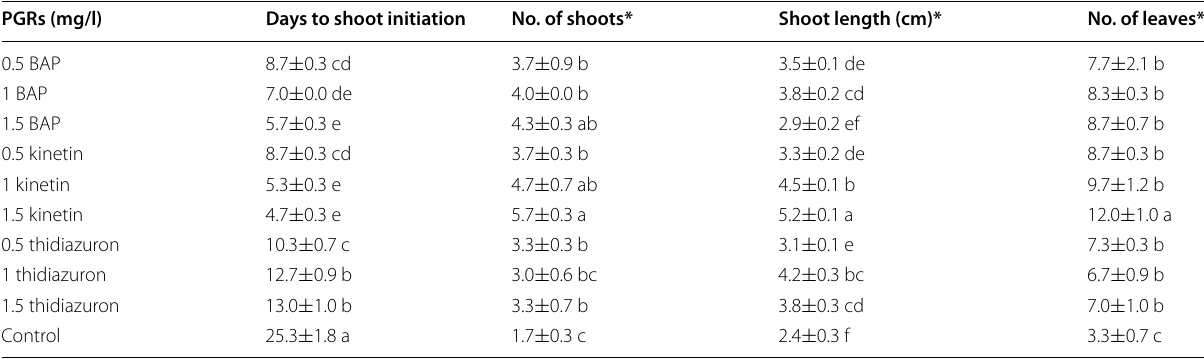
*Data recorded after 6 weeks of culture Data (mean standard error) represent three replicated treatments with 20 calli (each weighing 500 mg) per replication (control ± each column followed by the different letters are significantly different according to Tukey’s test at P